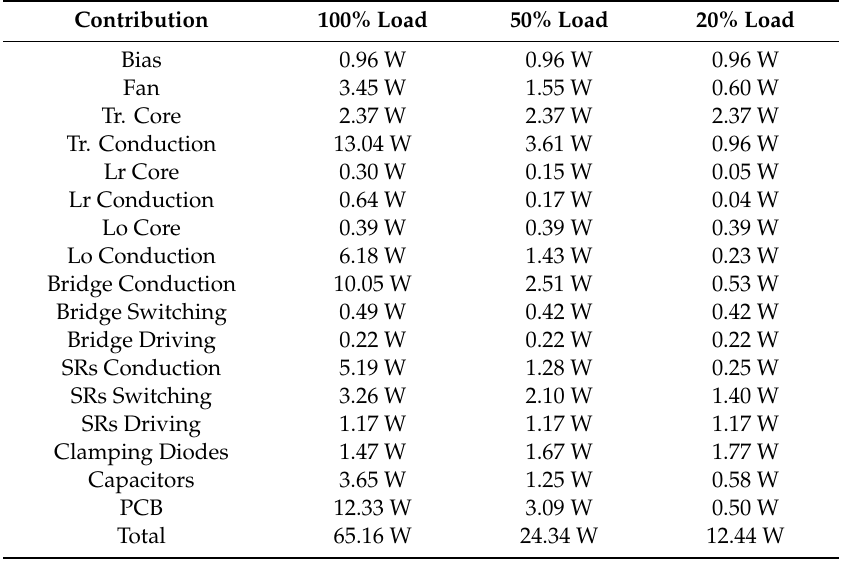
Table 12. Summary of the distribution of losses in the optimized design.